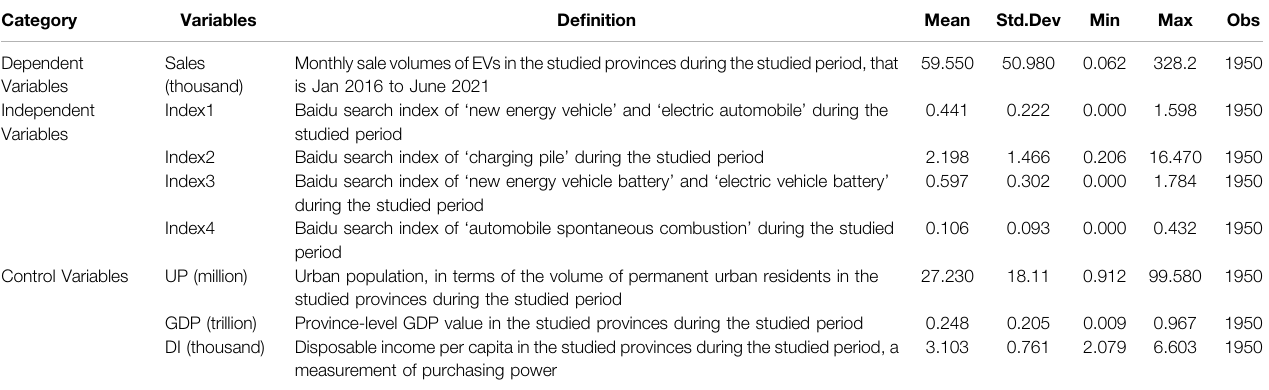
TABLE 2 | De fi nitions of variables and descriptive statistics.